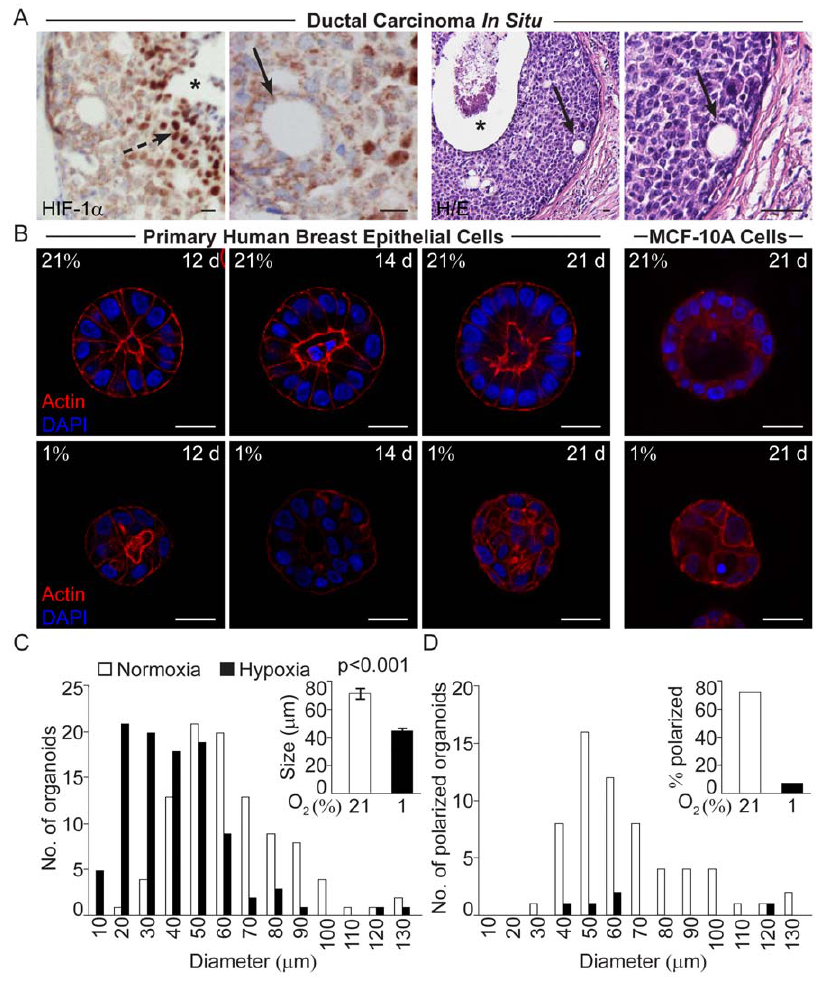
Figure 1. Loss of polarization in hypoxic breast epithelial cells. A. Positive HIF-1 a IHC staining of hypoxic cells (broken arrow) adjacent to the necrotic zone (star) in ductal carcinoma in situ of the breast. Small duct-like formations (arrows) in non-hypoxic regions close to the basal membrane in two different patient specimens of ductal carcinoma in situ . H/E; haematoxylin/eosin staining. Size bars 20 m m. B . Size and polarization of human breast epithelial cell acini grown on ECM-derived substrate at 21% and 1% oxygen. Actin (phalloidin, red) and nuclear (DAPI, blue) staining of normoxic (upper panel) and hypoxic (lower panel) primary human breast epithelial cells (left panels) and MCF-10A cells (right panel) at the indicated days post-seeding. The primary breast epithelial cell micrographs are from one representative time-series out of three sets of cultured breast cell samples from three different healthy women. All confocal micrographs were acquired at the Z-plane where the depictured acini-like structure had the widest circumference. Size bars 20 m m. C. Number of MCF-10A cell organoids of a given diameter (left) and the average size (right) of MCF-10A cell organoids cultured at 21% or 1% oxygen for 21 days on ECM-derived substrate. D. Number of polarized MCF-10A cell organoids of the given diameter (left) and the percentage of polarized organoids (right) after 21 days of culture on ECM-derived substrate at 21% or 1% oxygen. Data from one representative experiment out of three is shown. Organoids were considered polarized if 50% or more of the cells in the outer layer formed a palisade. MCF-10A cells differentiated into acini the basal accumulation of (Fig. 3, 4, and 5). In normoxic primary breast epithelial cell laminin 5 increased (Fig. 4B). At hypoxia, intra-cellular localiza- cultures, a 6-integrin localized to the basolateral surface of the tion of laminin 5 was evident at all time-points studied (Fig. 4B), entire acini-structures (Fig. 3A). At hypoxia, this uniform although weak at day 3 post-seeding. The ratio of intra-cellular to localization was disrupted (Fig. 3A). The ratio of cytoplasmic to basal membrane localization was significantly increased in hypoxic basal expression was significantly increased in the breast epithelial compared to normoxic MCF-10A organoids (p = 0.011, Fig. 4C). cells of hypoxic organoids 21 days post-seeding (p = 0.014, Fig. 3C). In the primary human breast epithelial cells laminin 5 was In MCF-10A, the polarized rim-cells had basolateral a 6-integrin generally more difficult to detect (Fig 4A, B), but quantitative localization (Fig. 3B), while the hypoxic MCF-10A cell organoids analysis of the ratio of cytosolic to basal membrane localization displayed a reduced and non-polarized expression of a 6-integrin, revealed a significant increase in cytosolic localization, i.e. with significantly increased ratio of intra-cellular to basal decreased polarization (p= 0.039, Fig. 4C). expression compared to normoxic cells (p , 0.0001, Fig. 3B and C). Laminin 5 was barely detectable in MCF-10A cells 3 days post- seeding in both normoxia and hypoxia (Fig. 4B). As the normoxic